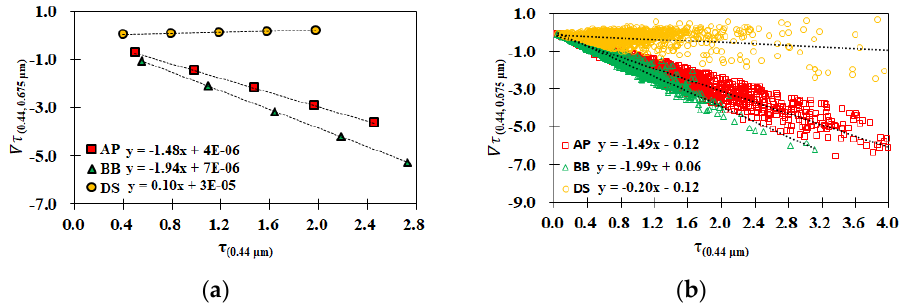
Figure 5. AOD gradients ( (0.44, 0.675 μ m) ) of DS (yellow), BB (green) and AP (red) aerosols along with AOD (0.44 μ m) from ( a ) 6S model simulation and ( b ) AERONET measurements.